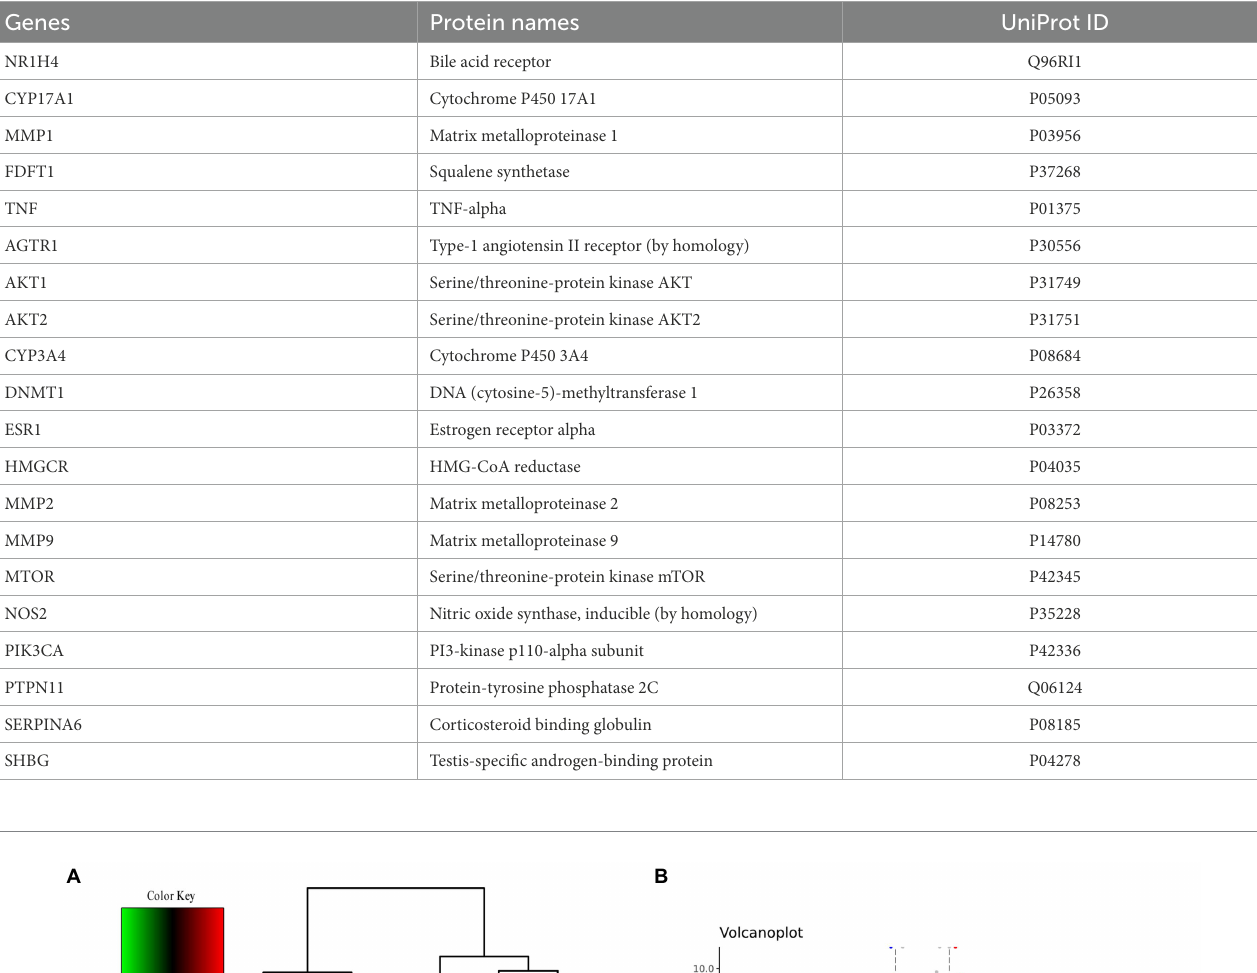
TABLE 2 Twenty key target genes of Resinacein S related to NAFLD. Genes Protein